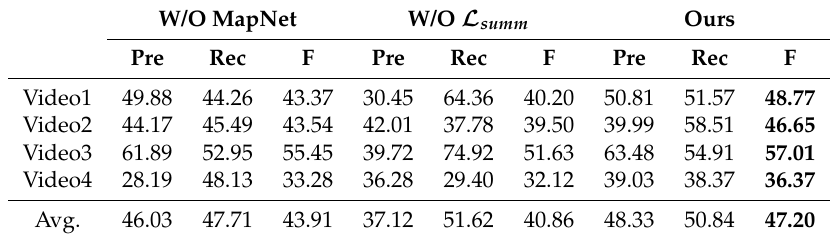
Table 2. We compare the proposed model to two models, one that does not make use of MapNet, and one that does not make use of the ground-truth loss L summ , but that are identical otherwise. The best results (F-measure) are highlighted in